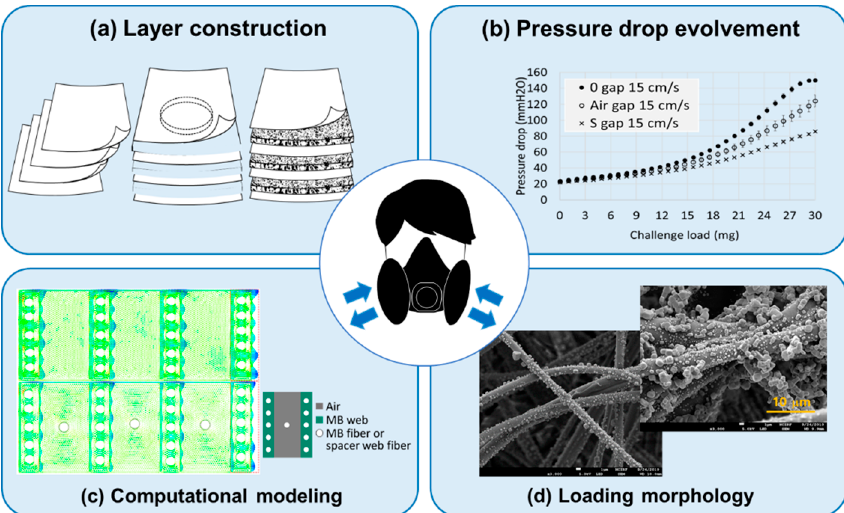
Figure 1. Schematic overview of study. ( a ) Filter layer construction was varied with multilayers of meltblown filter web, ( b ) Pressure drops of different layer-constructions were investigated, ( c ) Computational modeling was conducted to interpret the pressure drop behavior of different constructions, ( d ) Loading morphology of different constructions were investigated.